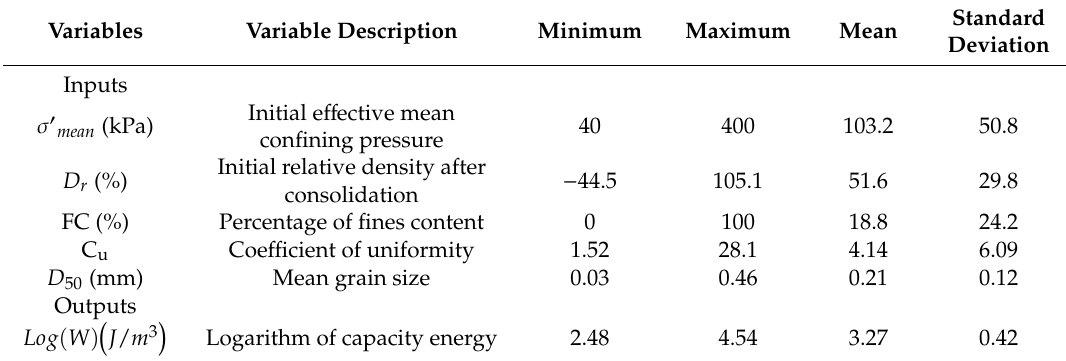
Statistics of parameters used for Multivariate Adaptive Regression Splines (MARS) model